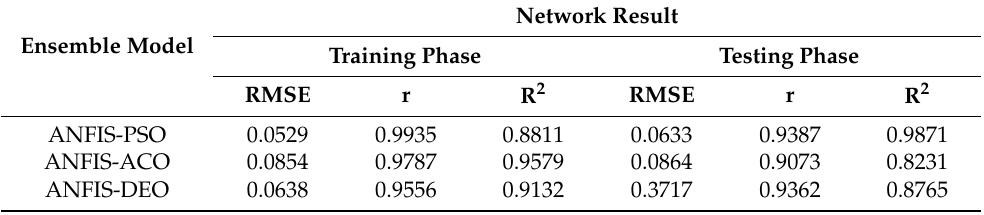
Table 9. The calculated accuracy criteria for the performance of the implemented